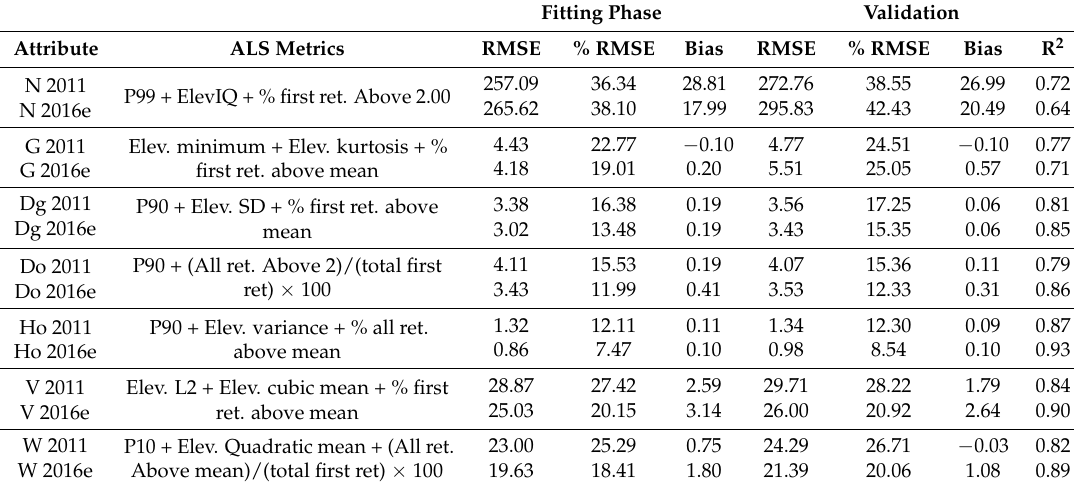
Table 5. Summary of the best-selected SVMr 2011 models and 2016 extrapolated ones. ret. refers to returns; e is extrapolated; N is stand density; G is basal area; Dg is squared mean diameter; Do is dominant diameter; Ho is dominant height; V is timber volume over bark of stem; W is total tree biomass.